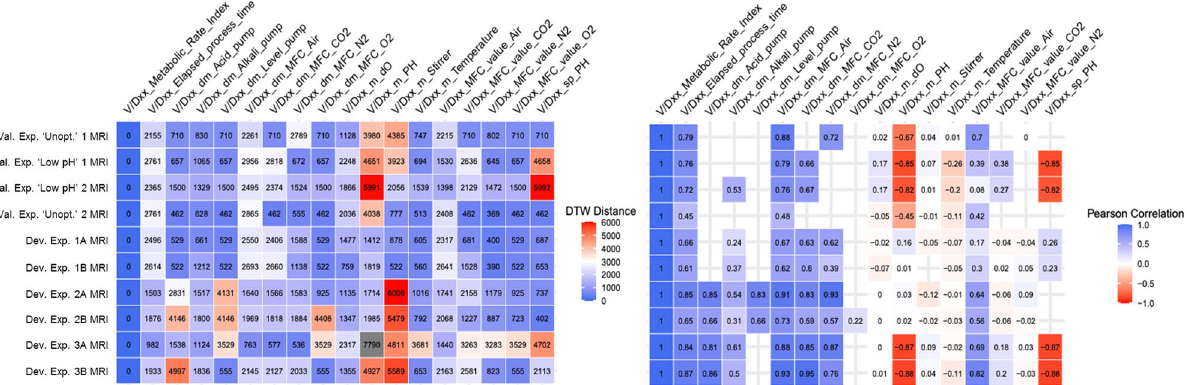
Figure 6. Dynamic time warping distance matrix (left) and Pearson correlation matrix (right). The matrices show the respective similarity metric for the MRI of each run and all online parameters of the same run. DTW distance was capped at approximately 6000, DTW distances exceeding 6000 are displayed in grey. Empty places in the Pearson correlation matrix indicate that the concerned feature did not show any variance, hence, the correlation was mathematically not defined. This figure was generated using R (v. 4.0.3) in RStudio (v. 1.1.463) using the plotting packages “cowplot” (v. 1.1.0) and “ggplot2” (v. 3.3.2). R link: https:// mran. micro soft.